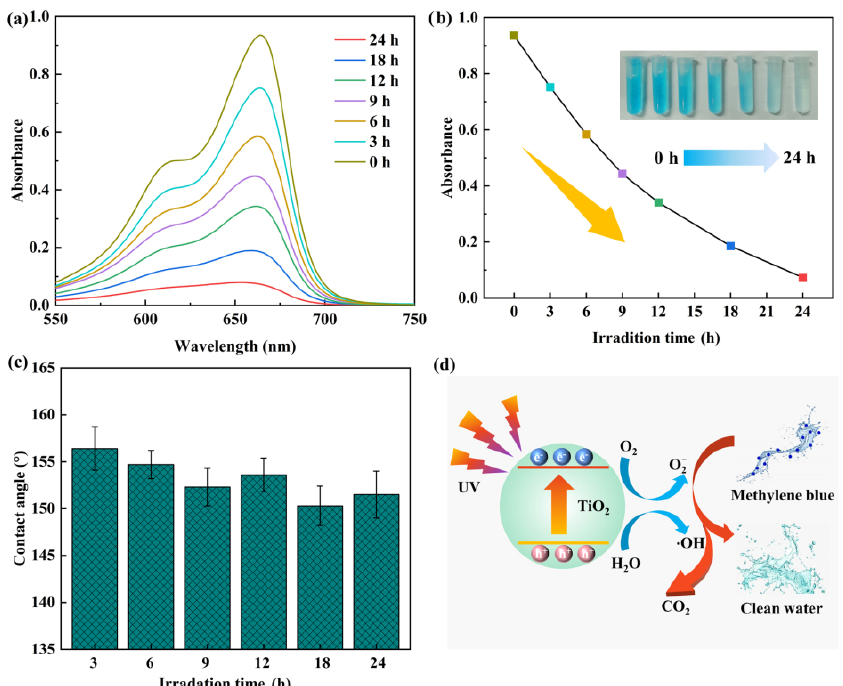
Fig. 13 (a) Absorption spectra of MB solution exposing UV at different irradiation times. (b) Absorption and colors of MB solution as a function of time. (c) CAs of the decoupling coating after immersion in MB solution for different times. (d) Mechanism of photocatalytic degradation for MB solution by the decoupling